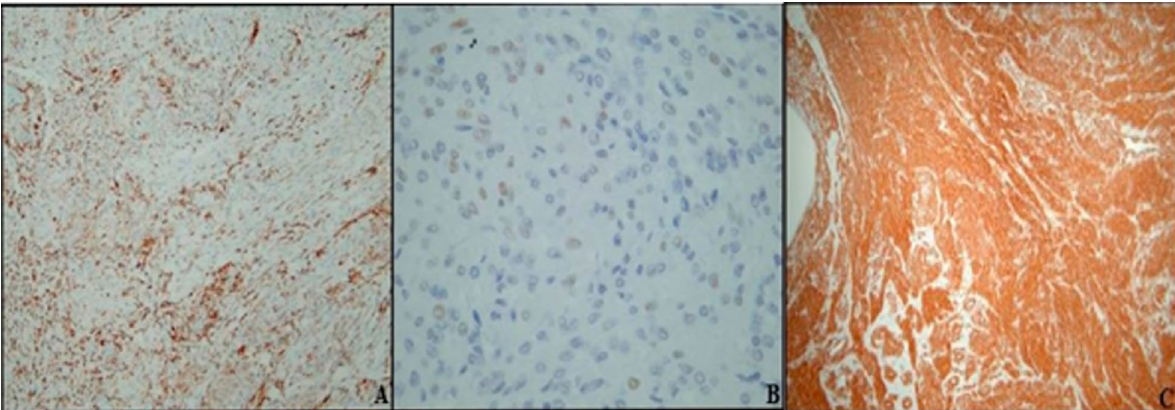
Fig. 2 AMLEC (IHC: Immunohistochemistry). A HMB45 positive staining in the spindled cells spindled cells 400. C SMA staining the spindled cell ×